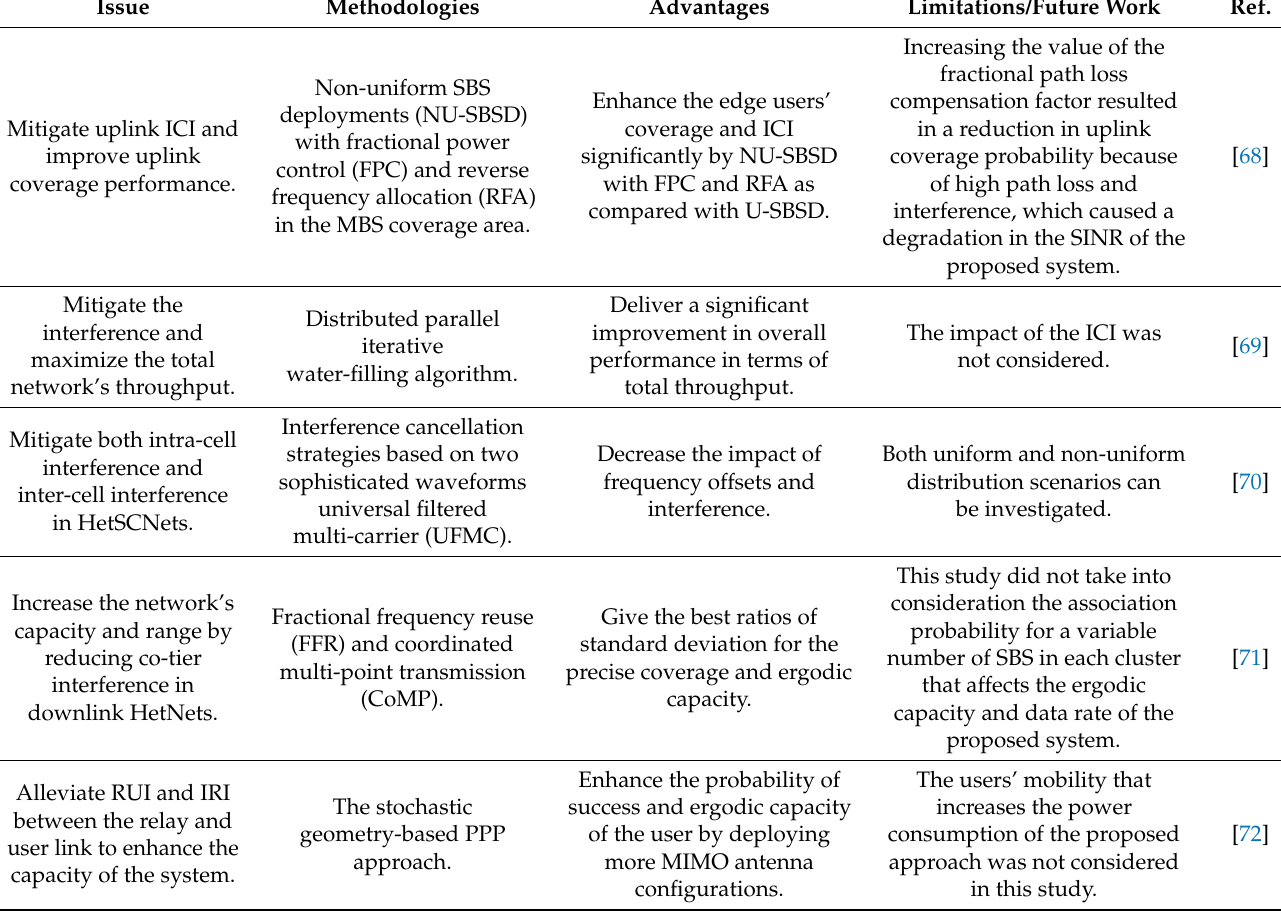
Table 2. The summary of related works of HetNets in the